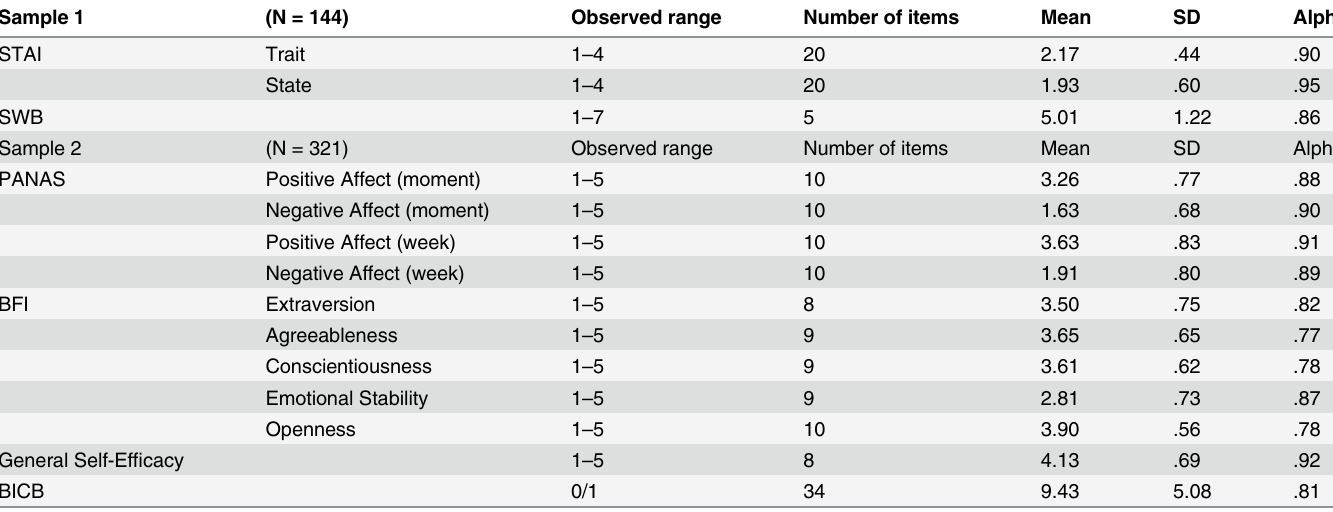
Table 4. Descriptive Statistics and Internal Consistencies of the Used Questionnaires and Their Subscales. Sample 1